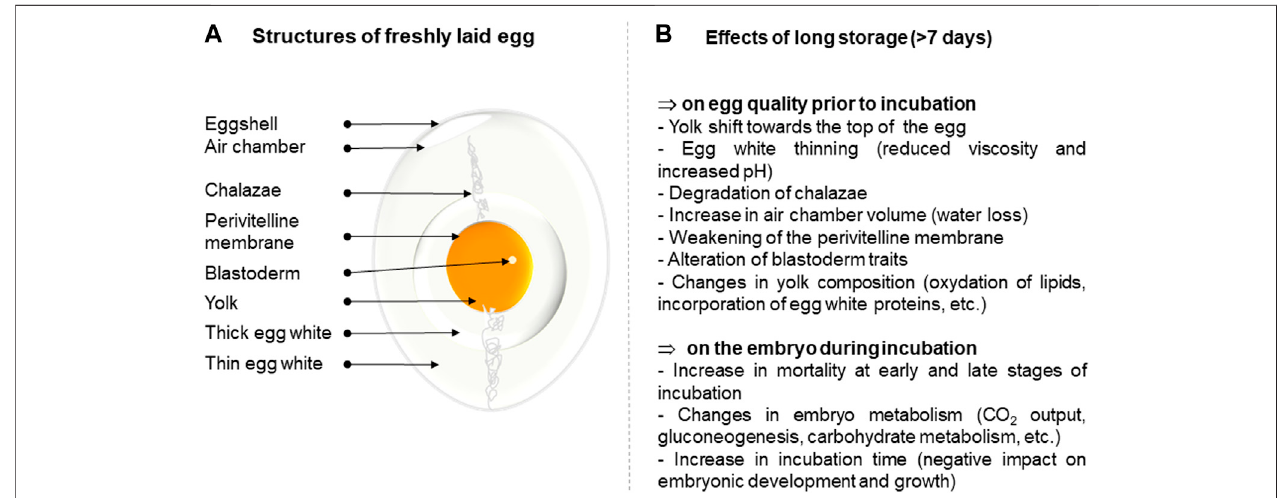
FIGURE1 | Summary ofthe effect oflong-termstorageon egg quality and subsequent development ofthe embryo. (A) . Structure ofafreshly laidegg. (B) . Effects of long-term storage on egg parameters.